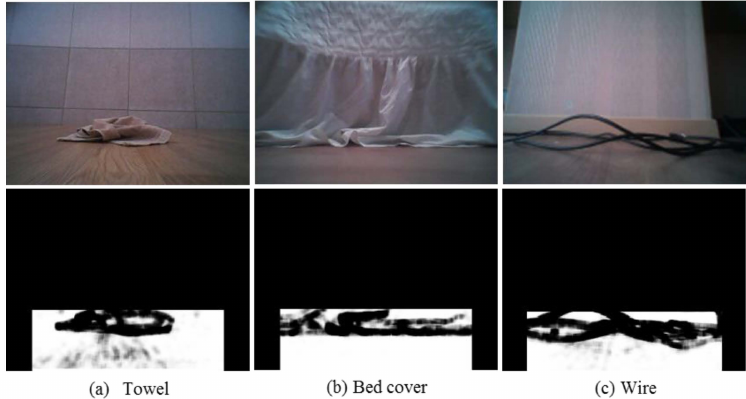
Figure 7. Metric tensor based texture feature extraction converted to 8-bit grayscale image in the